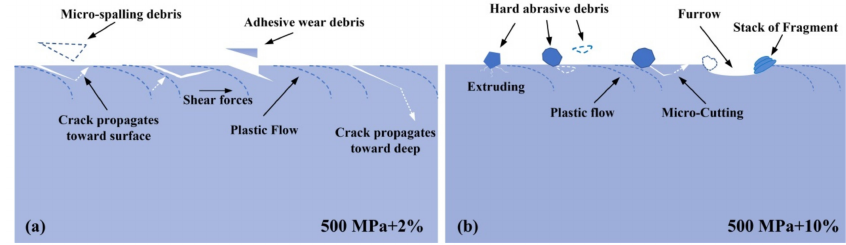
Figure 12. Wear mechanism maps at the condition of ( a ) 500 MPa + 2%, ( b ) 500 MPa +